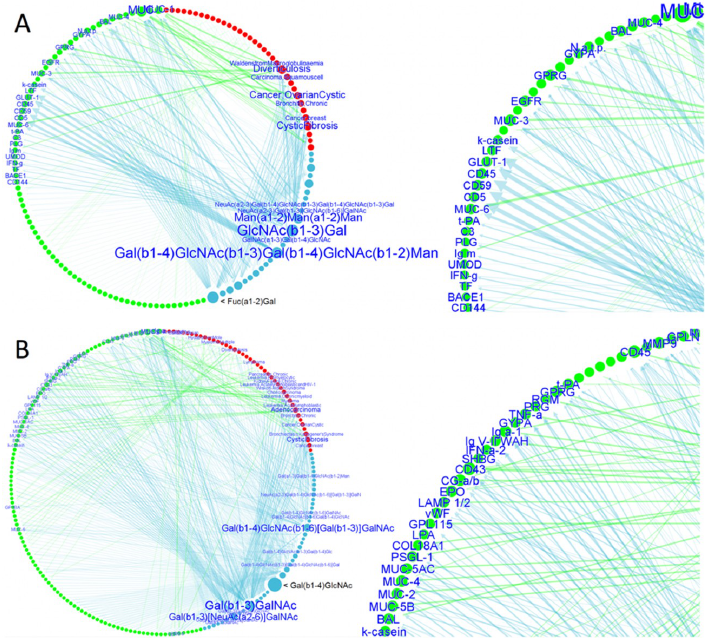
Figure 9. Lectin‐glycan interaction networks (LGI) of agglutinin‐like sequence (Als) and epithelial adhesins (Epa) proteins. Glycan determinant data and their connections with human glycoproteins and related diseases are depicted for C. albicans Als proteins (N‐Als1p and N‐Als3p) ( A ) and Epa proteins (N‐Epa1p, N‐Epa5p, and N‐Epa7p) ( B ). Reprinted with permission from [112]. Close‐up views of the networks are shown on the right. The nodes’ dimensions and the arrow thickness/label size depend on the number of connections and the glycan‐binding strength, respectively. Notably, the determinants Fuc( α 1-2)Gal ( A ) and Gal( β 1-4)GlcNAc ( B ) are both characterized by a high